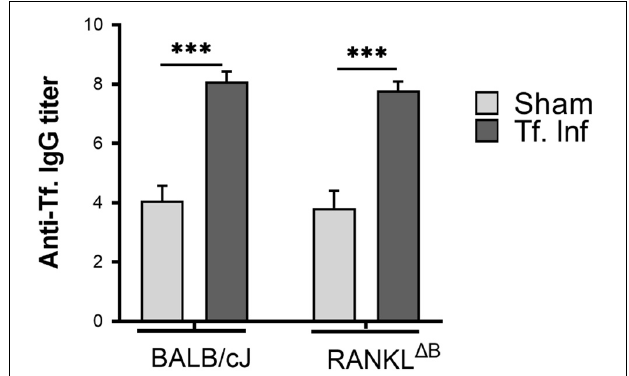
FIGURE 4 | Deletion of RANKL in B cells did not alter the IgG response. Sera was collected from sham and T. forsythia infected mice (BALB/cJ and RANKL (cid:49) B ) and analyzed for T. forsythia -specific IgG by ELISA. Antibody levels are presented as log 2 titers. Data are the means and standard deviations for each group ( n = 8); ∗∗∗ P < 0.001 vs the sham-infected